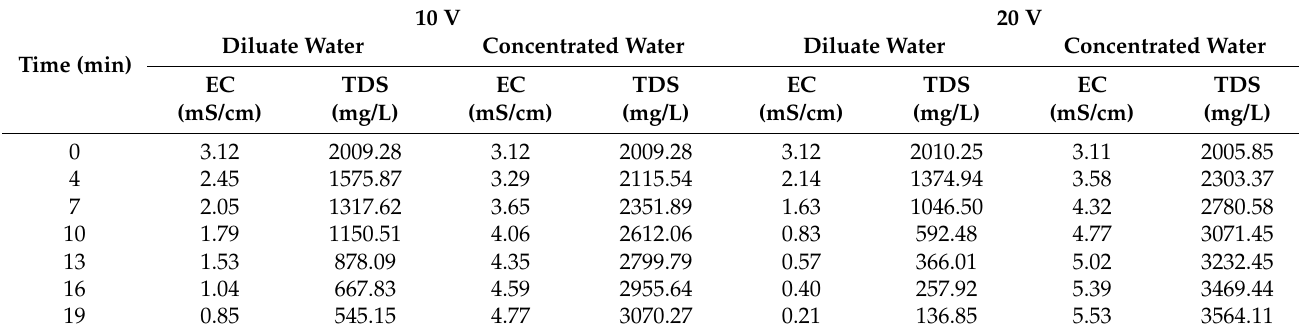
Table A2. Desalination results for the 2000 mg/L TDS sample at 30 ◦ C.